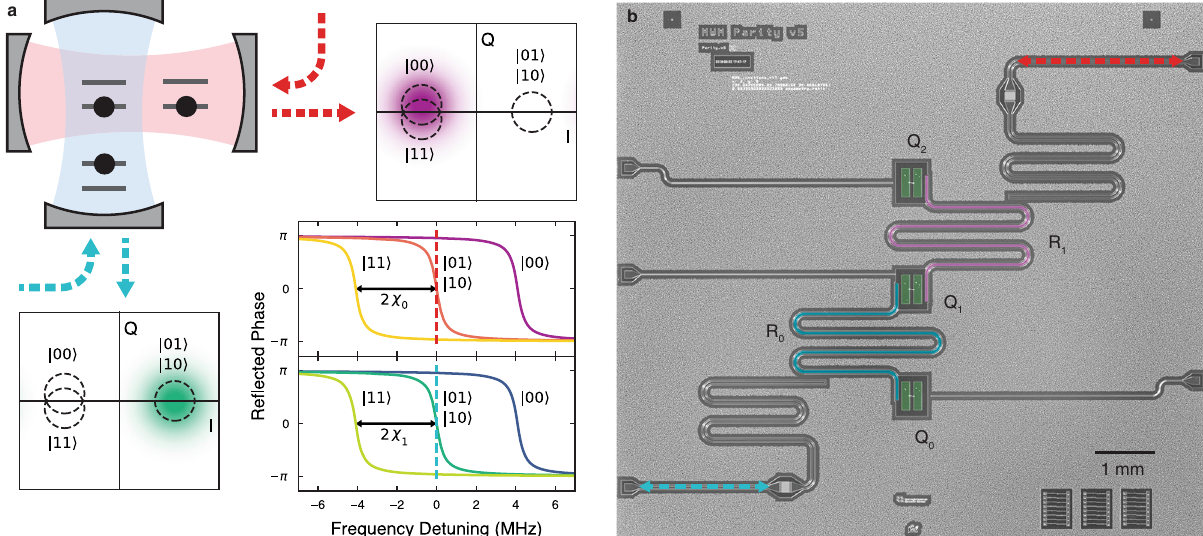
Fig. 1 Full parity detection. a Three qubits in two cavities, with each cavity implementing a full parity measurement. Lower right: ideal phase responses of a coherent tone re fl ected off each cavity for different qubit states. The parity probe tones are centered on the odd-parity resonances. The phase space (IQ) plots show the ideal steady state re fl ected tone for the shown qubit con fi guration. Dashed circles are centered on all possible steady state responses. b Micrograph of the superconducting chip with three transmons and two joint readout resonators. R i labels the resonators and Q j labels the qubits. a b